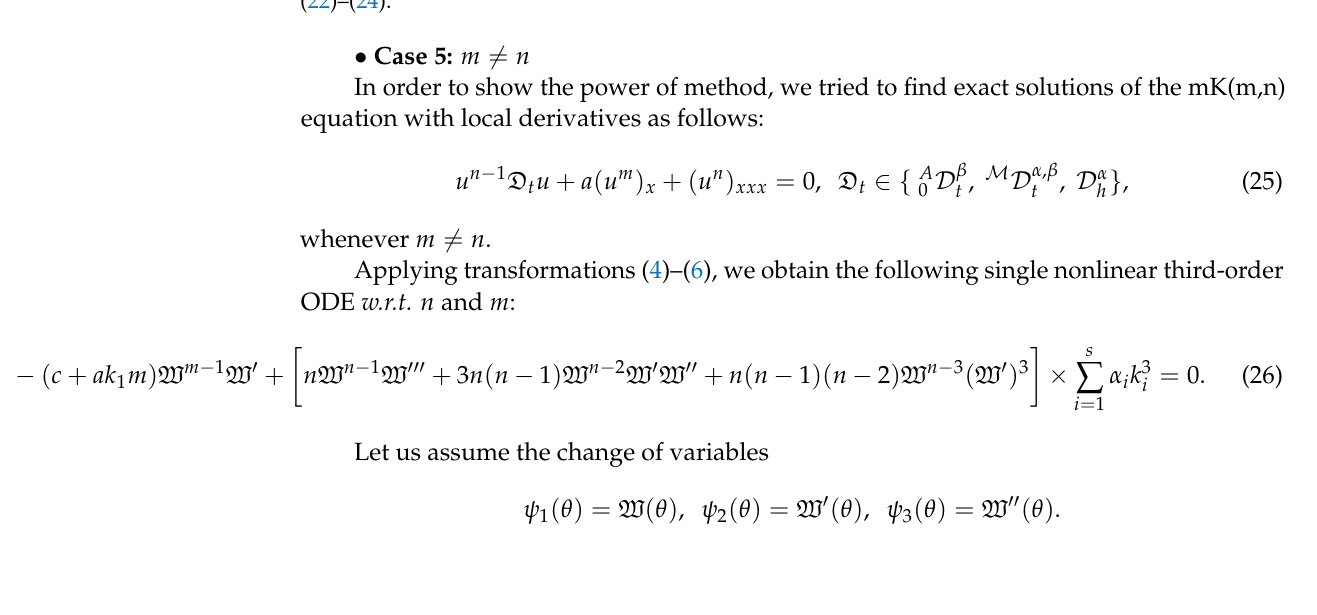
Figure 8. Exact solutions with k 1 = α 1 = a = c = 2, λ 3 = t = 1, m = 3, and ( a ) n = 1.5, β = 0.9, and various α w.r.t. M-derivative (22), ( b ) n = 2, and various β w.r.t. beta-derivative (23) ( c ) n = 2, and various α w.r.t. hyperbolic-derivative (24) ( d ) n = 2, α = β = 0.8, and various derivatives in